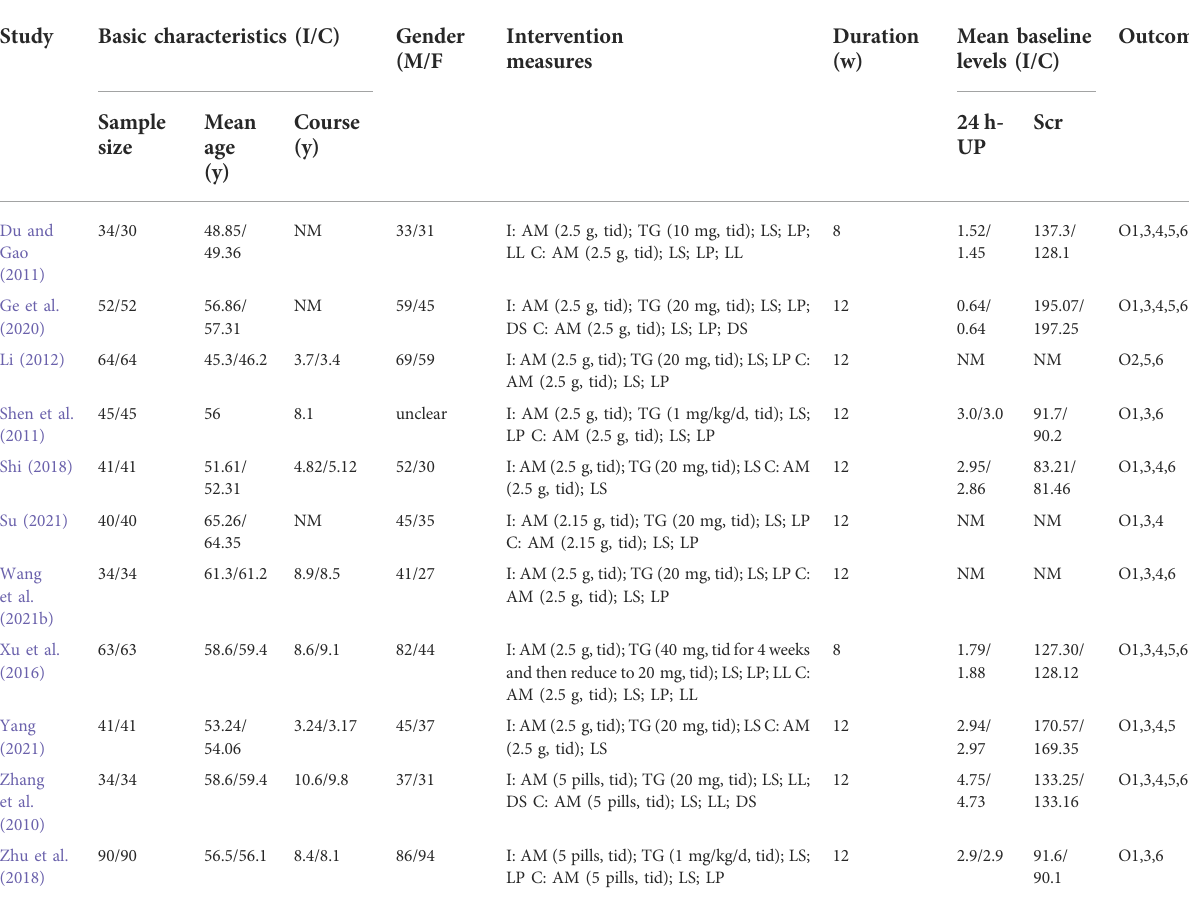
TABLE 1 Basic characteristics of the included